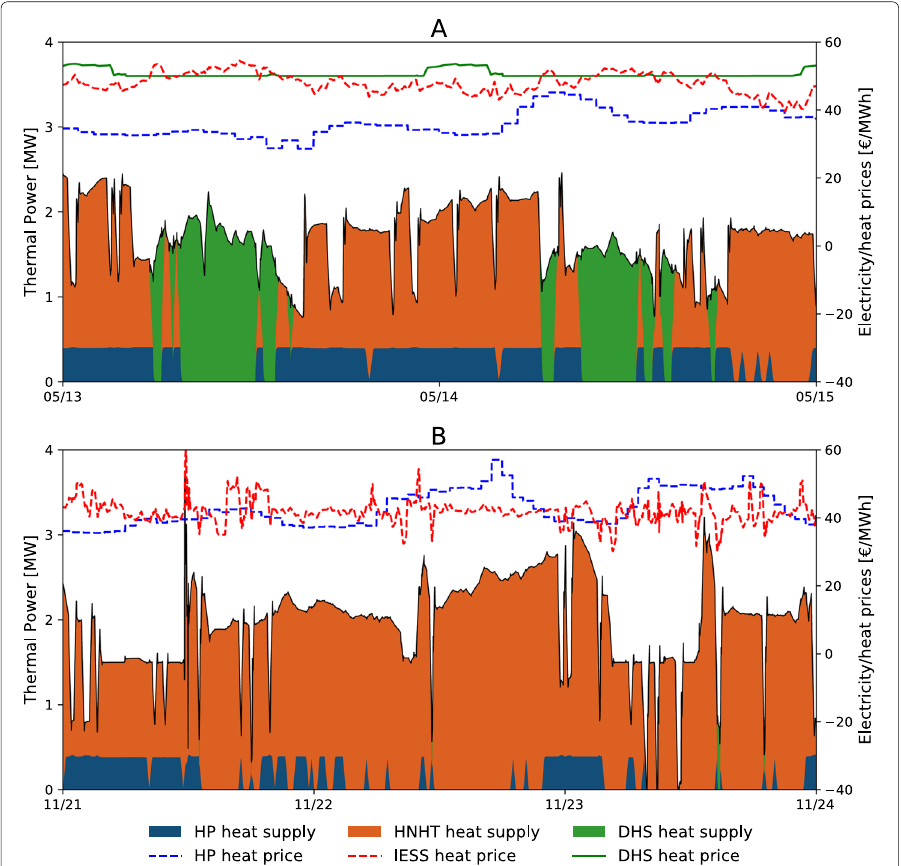
Fig. 6 Analysis of the energy flexibility of the HTS: A Flexible thermal energy exchange between different heating networks, B Power to heat